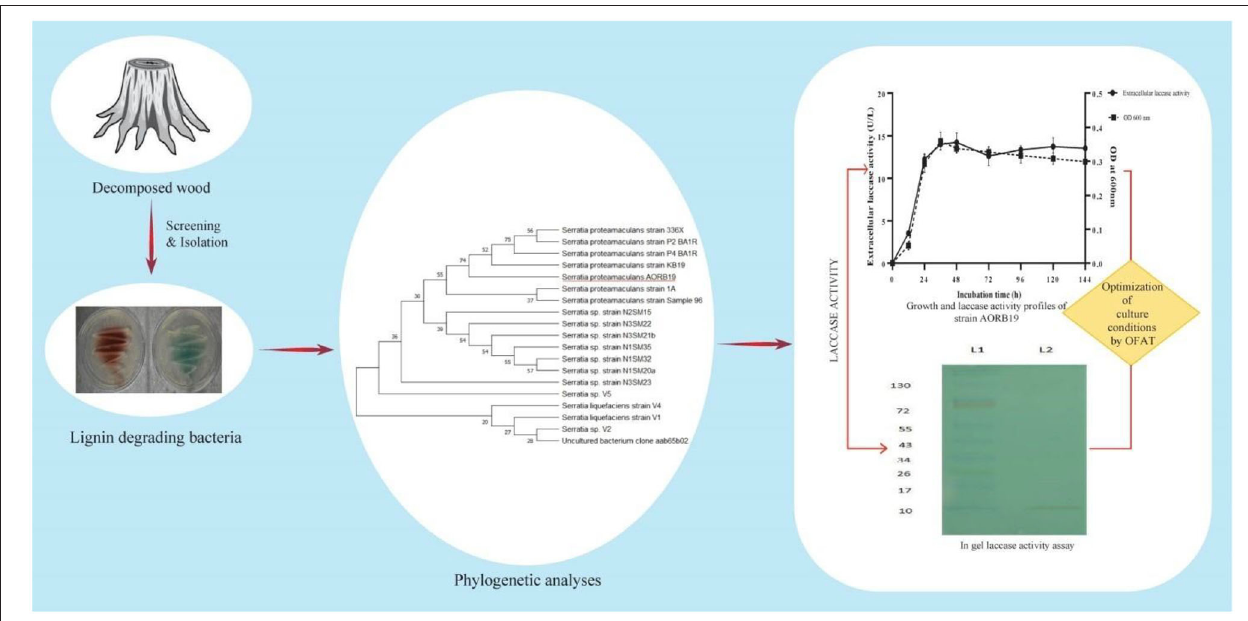
FIGURE 5 | Schematic representation for identification and characterization of laccase producing bacterial strain